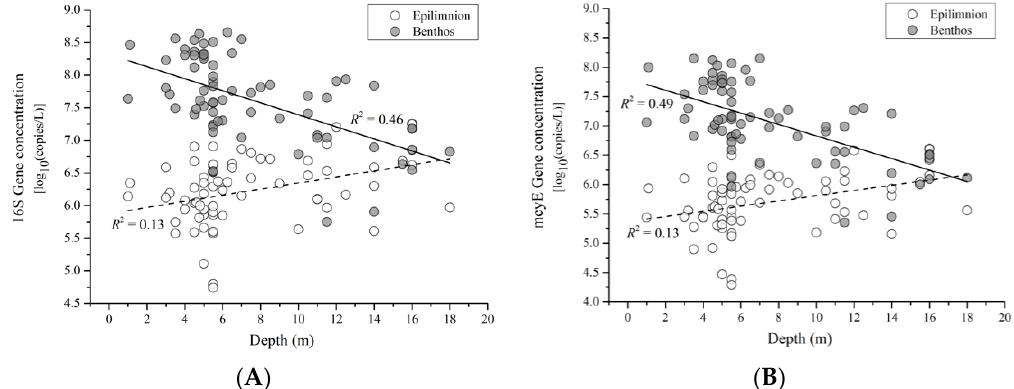
Figure 4. Depth-dependent distribution of overwintering Microcystis populations. Visualization of significant interaction effects from the GLMs using concentrations of M. aeruginosa ( A ) 16S rRNA and ( B ) mcyE gene copies as the dependent variables. ( A , B ): interaction effect between water column level (near-surface and near-bottom) and lakebed depth.